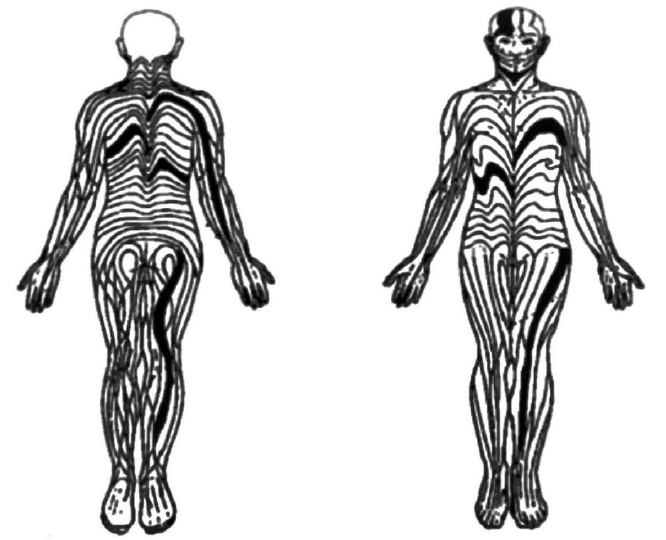
Figure 2. Blaschko’s lines, posterior and anterior views, as illustrated in the 1901 supplement to the Proceedings of the German Dermatological Society meeting [19].